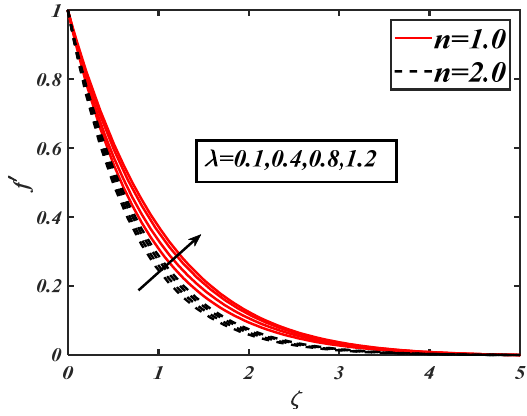
′ . Figure 3. λ illustration against f (cid:48) . ′ .